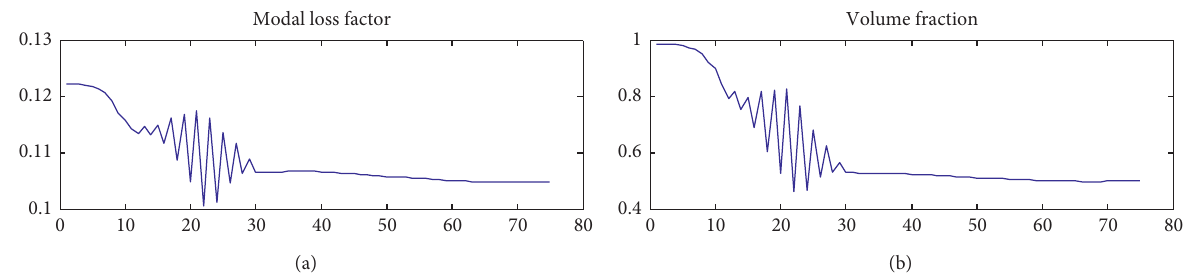
Figure 11: Convergence curves of the modal loss factor (a) and volume fraction (b) of the damping layer for the 5th modal with one hole as the initial design ( τ � 0 . 6).